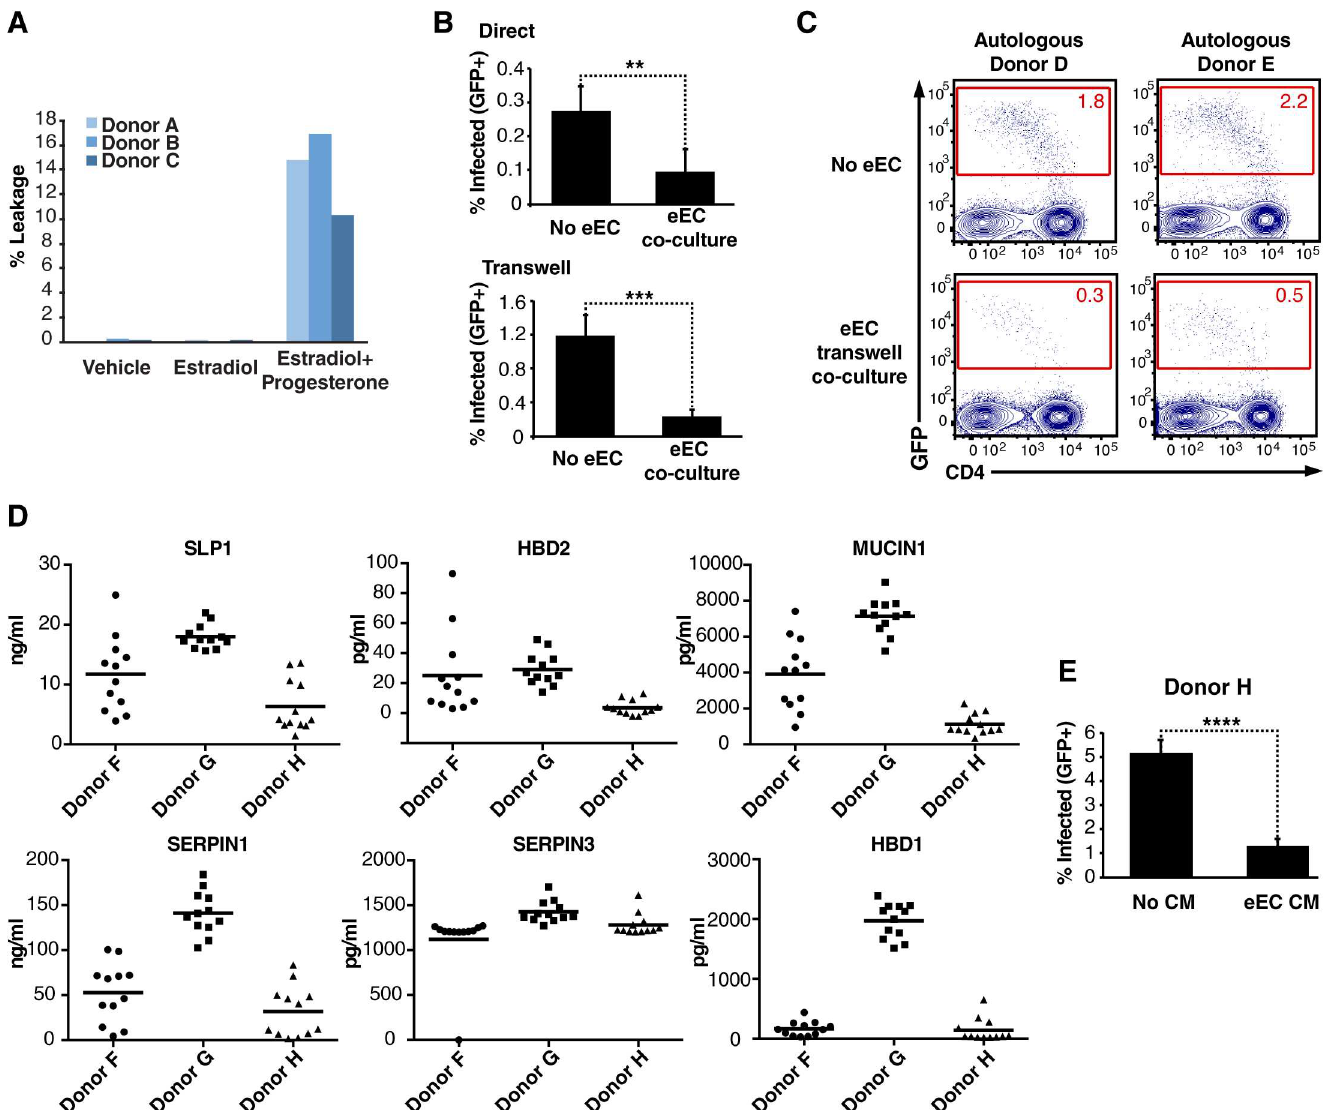
Fig 5. eEC inhibit HIV infection of CD4+ T cells and secreteantivirals. (A) eEC from 3 donors were co-culturedin a transwellwith autologouseSF in the basolateral chamberfor 6–7days withouthormones(vehicle), with estradiol only(mimicking the follicularphase),or withboth estradiolandprogesterone (mimickingthe lutealphase).Epithelialpermeability was monitoredby quantitating leakageof phenolred from the apicalto the basolateral chamber. (B) PHA/ IL2-activated PBMCswereinfectedwith NLENG1I withor withouteEC co-culture, andmonitored3 d later for levelsof productiveinfection.PBMCswere eitherin directcontactwith eEC, or separatedfrom them throughuseof a transwell.Resultsare gatedon live, singletCD3+CD8- cells, andare representative of data from threedonors. ** p < 0.01, *** p < 0.001(by 2-tailed t test). (C) PHA/IL2-activatedPBMCs cultured withor withoutautologouseECwereinfected with NLENG1I andmonitored for infectionlevels3 d later. Resultsare gated on live, singletCD3+cells. (D) Secretedlevelsof the top six anti-HIVfactors overexpressed in eECrelativeto eSF. The levelsof SLPI, HBD2, SERPINA3, MUC1, SERPINA1, andHBD1werequantitatedin the culturemediaof eEC from three donors(12 culturesper donor)after 48 h. (E) Activated PBMCswereinfectedwithNLENG1Iwith or withouteEC-conditionedmediaandharvested 3 d later to monitorlevelsof productiveinfection. Dataare representative of three independent experiments withCM from threedifferenteECdonors.Results are gated on live, singletCD3+CD8- cells. **** p < 0.0001(by 2-tailed t